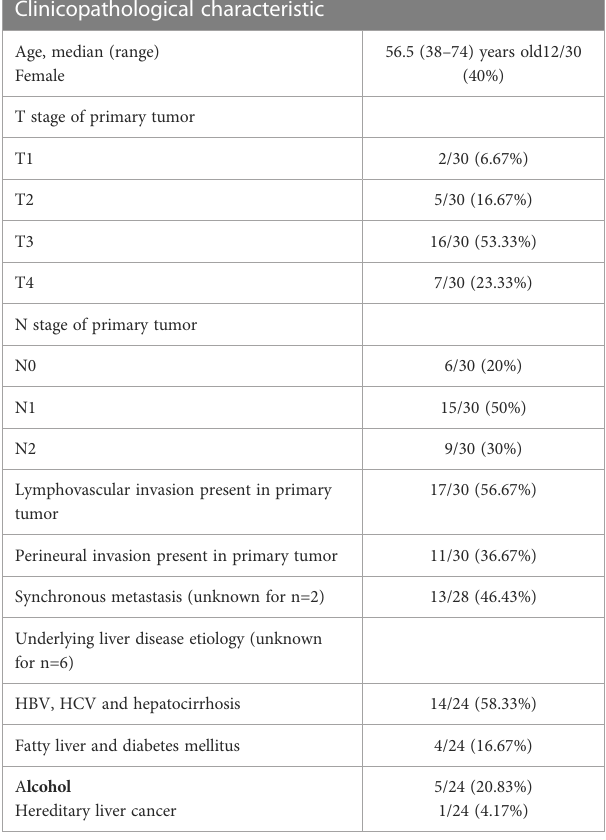
TABLE 1 Characteristics of patients and tumor samples studied